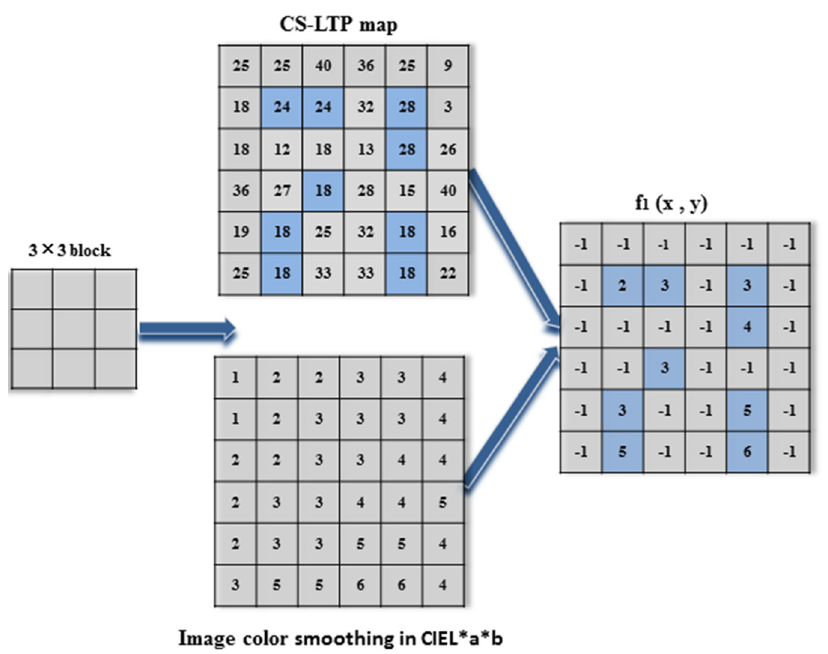
Figure 7. Illustration of producing a microstructure image f 1